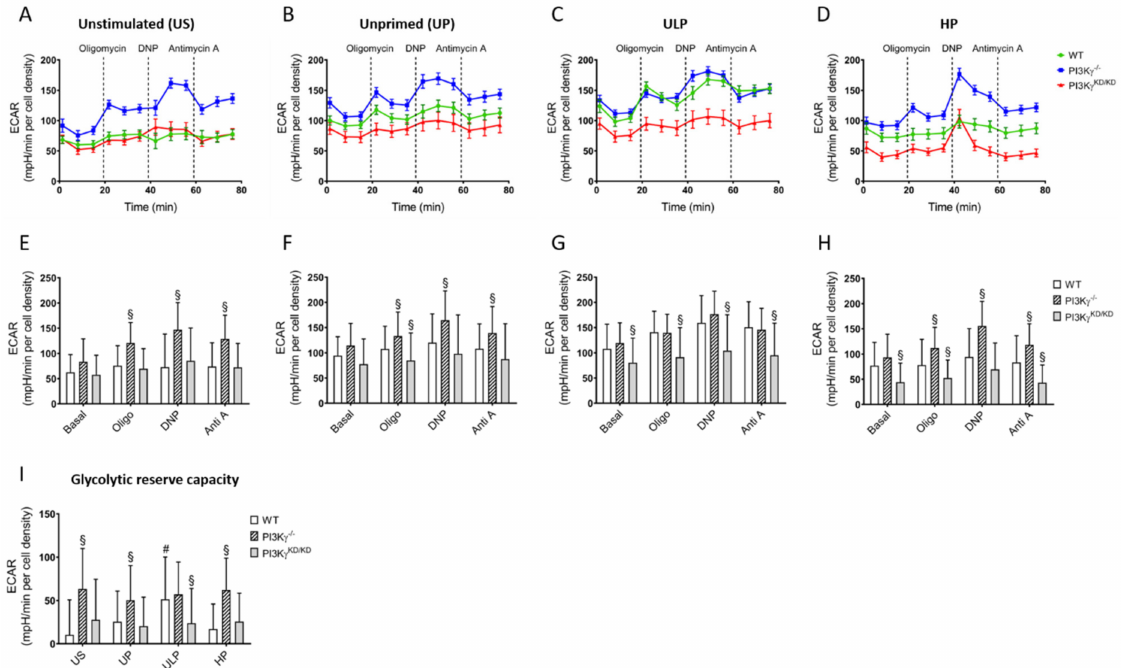
Figure 5. Lipid kinase-independent function of PI3K γ mainly mediates control of microglial glycolytic activity (ECAR). Microglia isolated from newborn mice (wild-type, open columns; PI3K γ -/- , hatched columns; PI3K γ KD/KD , dark gray columns; n = 5–6, repeated measurements, respectively) were primed initially by ultra-low (ULP, 1 fg/mL) or high (HP, 100 ng/mL) doses of LPS, followed by the second stimulation (day 6) with 100 ng/mL LPS. Time-dependent ECAR ( A – D ) dynamics were assayed using a Seahorse assay and quantified under unstimulated ( E ), unprimed ( F ), ULP ( G ) and HP ( H ) conditions. ( I ) Glycolytic reserve capacity was calculated from the ECAR values. Unstimulated microglia (US) served as the negative control. Data from ( A – D ) are given as means ± SEM, data from ( E – I ) are represented as means + SD, #§ p < 0.05, # vs. unprimed condition, § vs. the wild-type